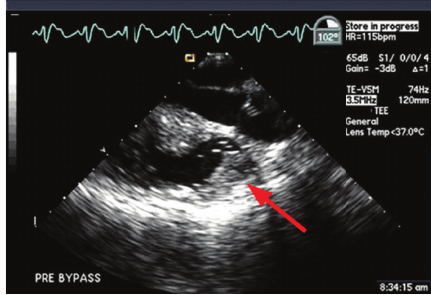
Figure 4: Intraoperative epicardial ultrasound imaging of the right ventricular outflow tract (RVOT) and pulmonary conduit. Arrow: filling defect obstructing the